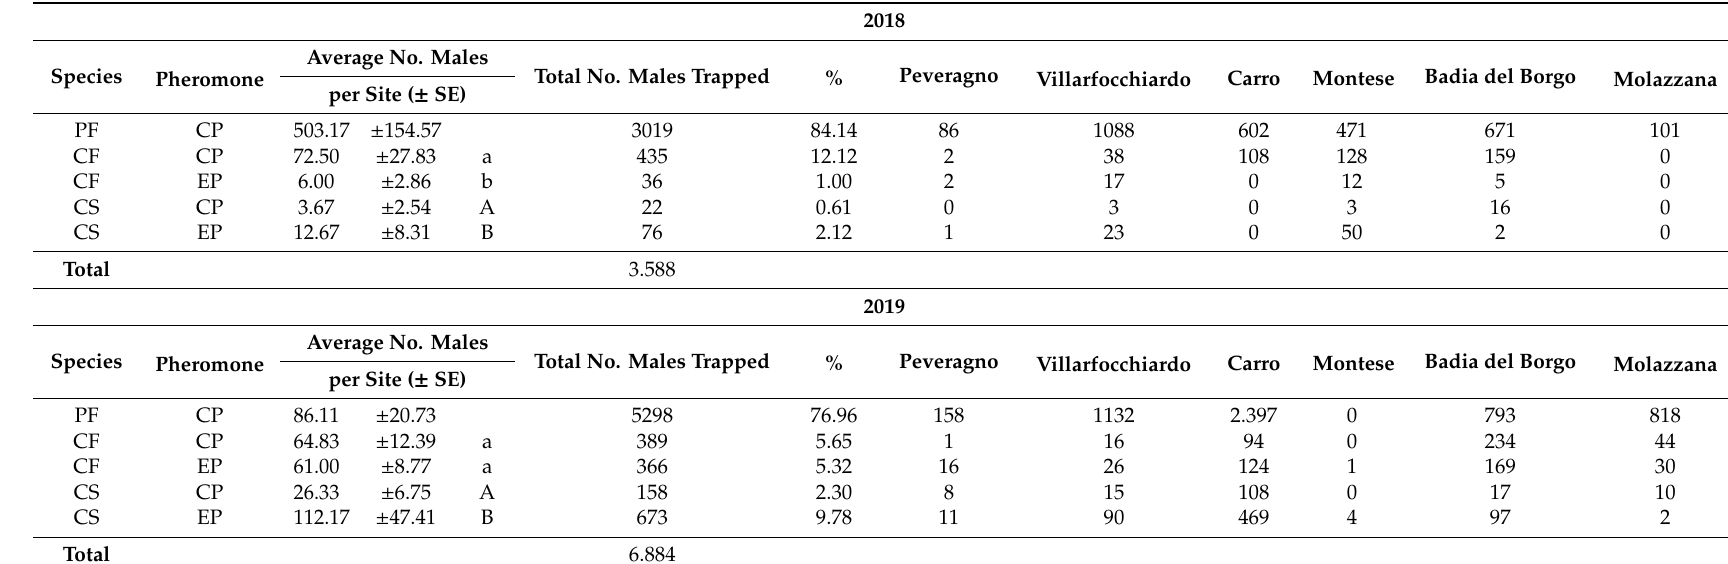
Table 2. Total number and percentage of males captured (across traps and lures) using sexual pheromone baited-traps in the two-year period 2018–2019 (PF, Pammene fasciana (L.); CF, Cydia fagiglandana (Zeller); CS, Cydia splendana (Hübner); CP, commercial pheromone; EP, experimental